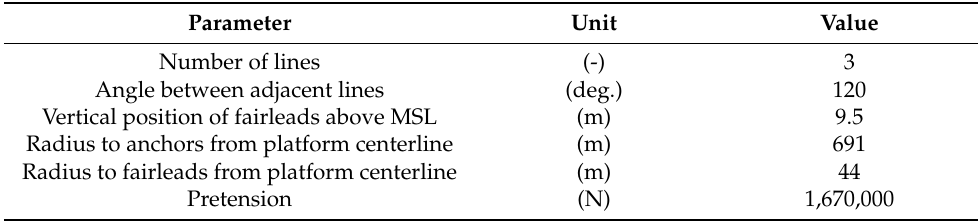
Table 1. Overall parameters of the DTU 10 MW reference wind turbine. Parameter Unit Value Rotor orientation (-) Clockwise, upwind Rated power (MW) 10.0 Rotor diameter (m) 178.3 Hub height (m) 119.0 Cut-in, rated, cut-out wind speed (m/s) 4.0, 11.4, 25.0 Minimum, maximum rotor speed (rpm) 6.0, 9.6 Rotor mass (kg) 228,000 Nacelle mass (kg) 446,000 Table 2. Overall parameters of the LIFES50+ OO-Star Wind Floater Semi. Parameter Unit Value Overall substructure mass (excl. tower, mooring) (kg) 21,709,000 Centre of mass (CM) below MSL (m) 15.255 Substructure roll inertia about CM (kgm 2 ) 9,430,000,000 Substructure pitch inertia about CM (kgm 2 ) 9,430,000,000 Substructure yaw inertia about CM (kgm 2 ) 16,300,000,000 Tower base interface above MSL (m) 11.0 Draft at equilibrium position with mooring (no thrust) (m) 22.0 Displaced water volume (m 3 ) Centre of buoyancy below MSL 14.236 Table 3. Overall parameters of the LIFES50+ OO-Star Wind Floater Semi mooring system. Parameter Unit Value Number of lines (-) 3 Angle between adjacent lines (deg.) 120 Vertical position of fairleads above MSL (m) 9.5 Radius to anchors from platform centerline (m) 691 Radius to fairleads from platform centerline (m) 44 Pretension (N)